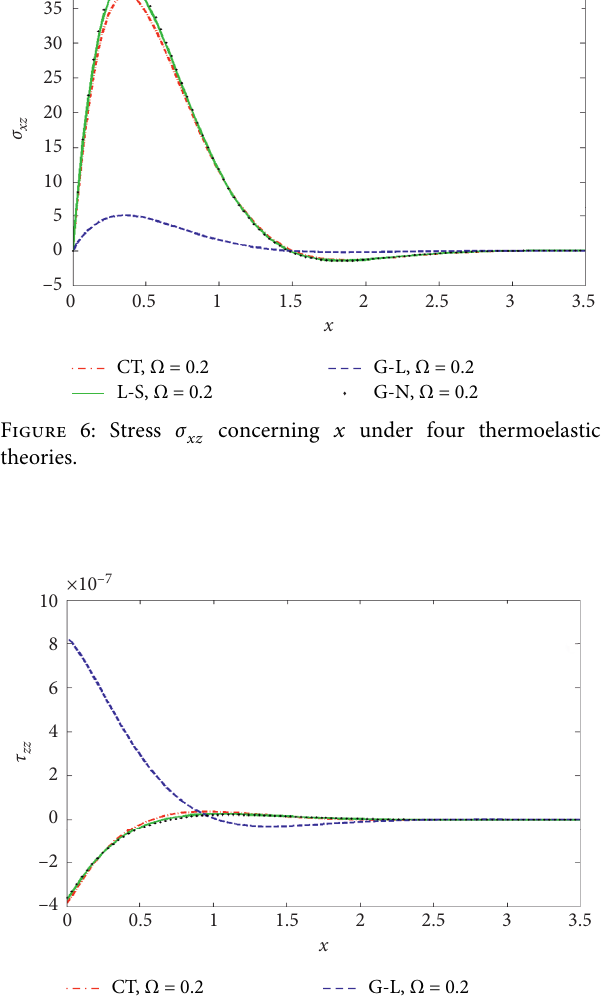
Figure 5: Stress σ theories.